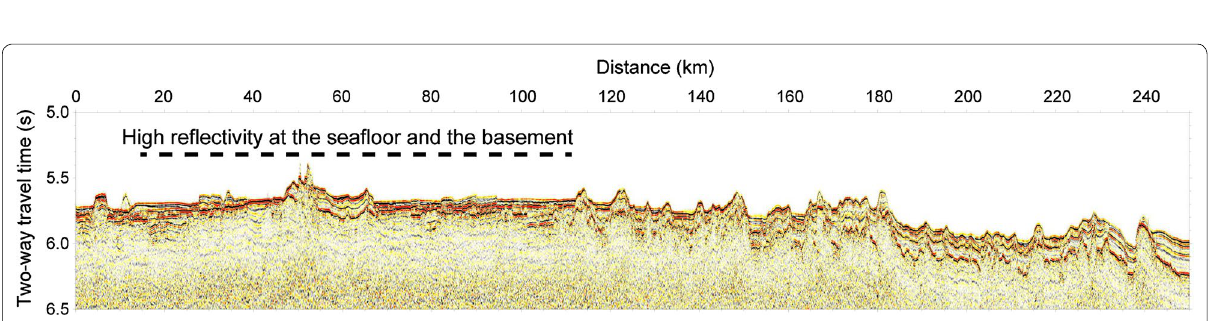
Fig. 4 Close-up image of the shallow part of the profile shown in Fig.